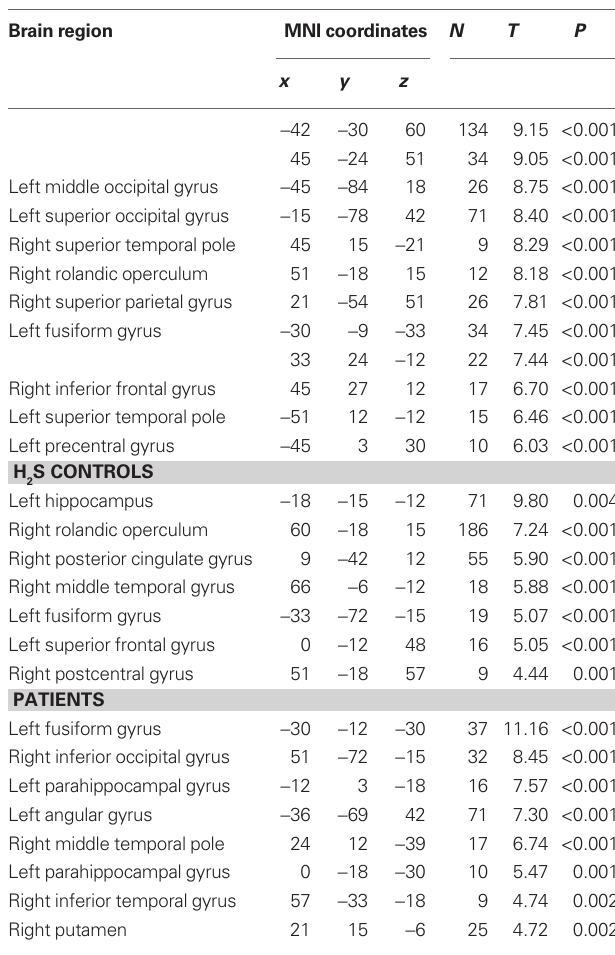
Table 1 | Single group